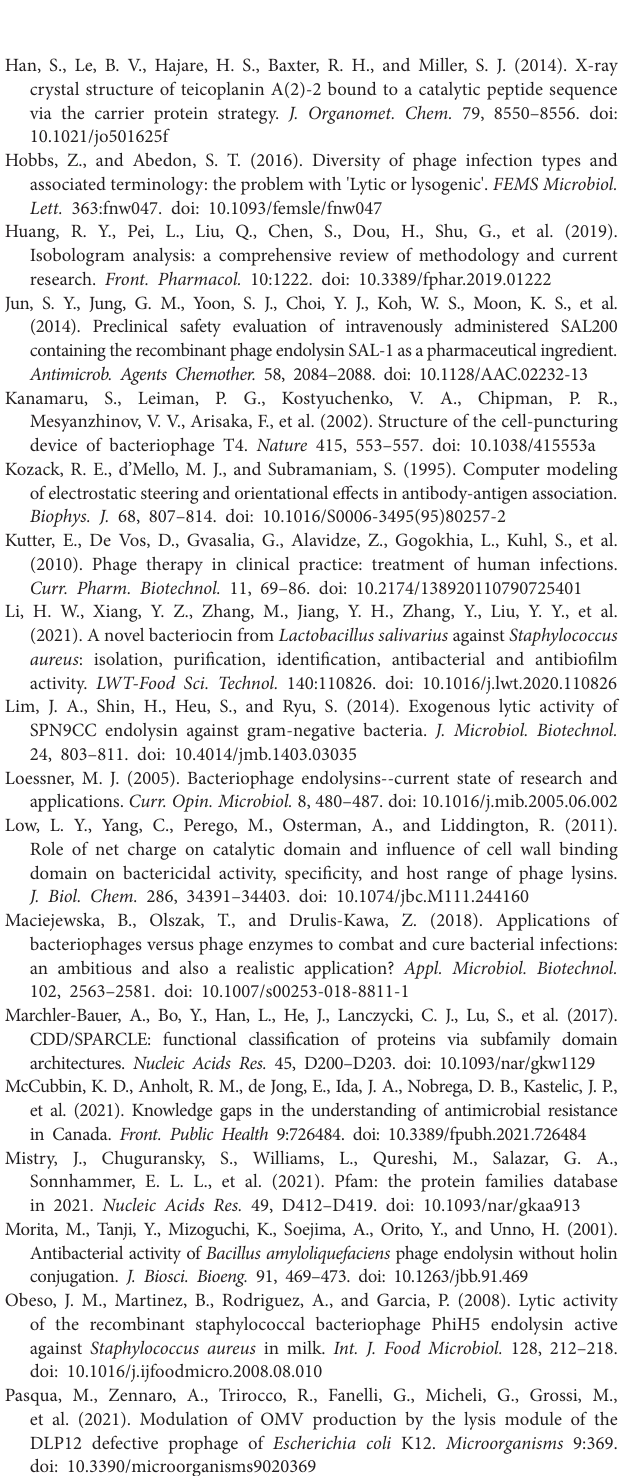
Supplementary Figure S1 | Combination of P9ly with ceftriaxone sodium (CRO) against different bacterial pathogens. (A) Shigella dysenteriae (KUST9); (B)